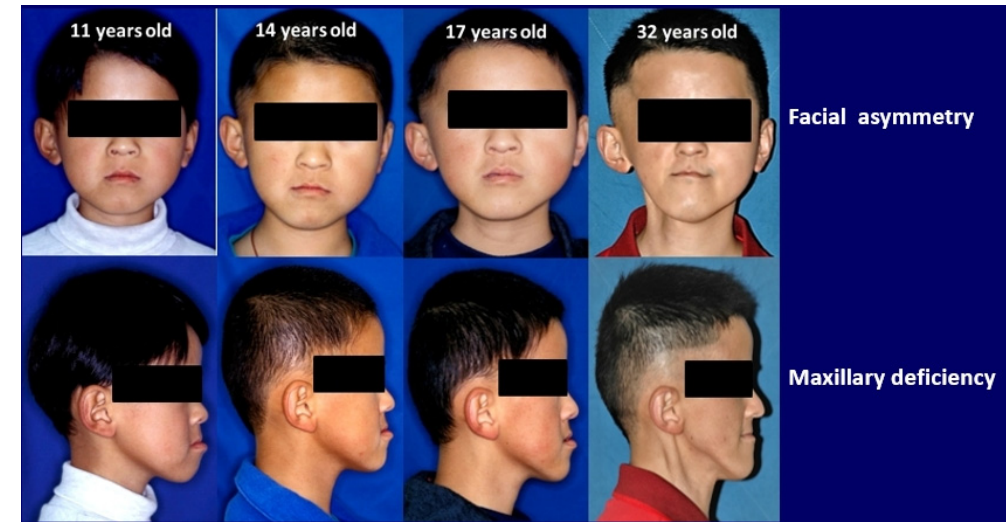
Figure 3. Long-term facial asymmetry as a result of pediatric rhabdomyosarcoma (RMS) cancer therapy.